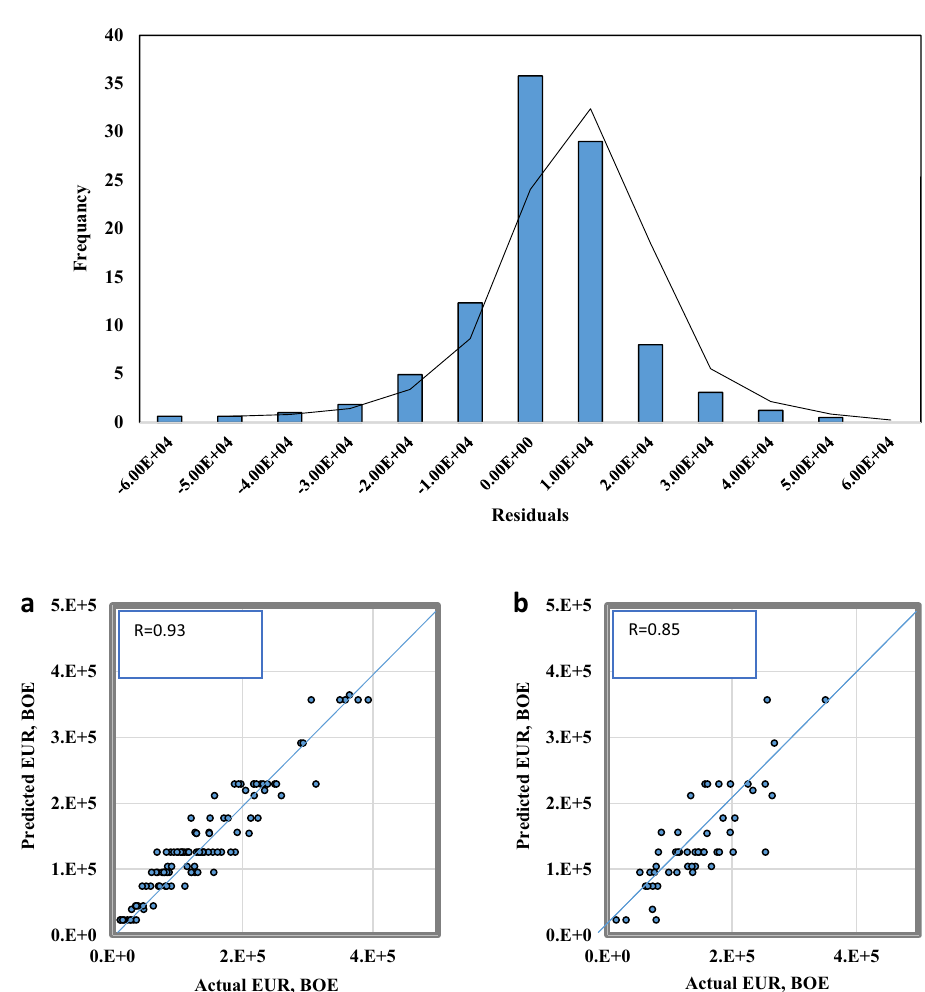
Fig. 8 Residuals distribution of the EUR predicted from RF- based model